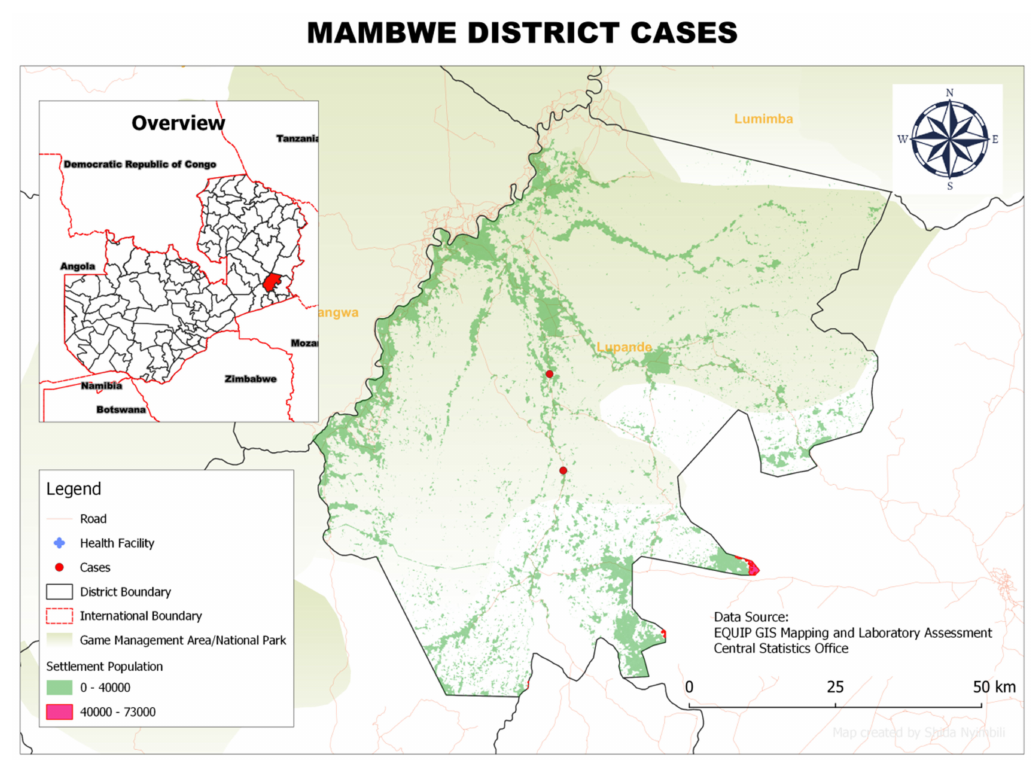
Figure 3. Spatial distribution of rHAT cases from 2004 to 2014 in Mambwe District, Eastern Province, Zambia.